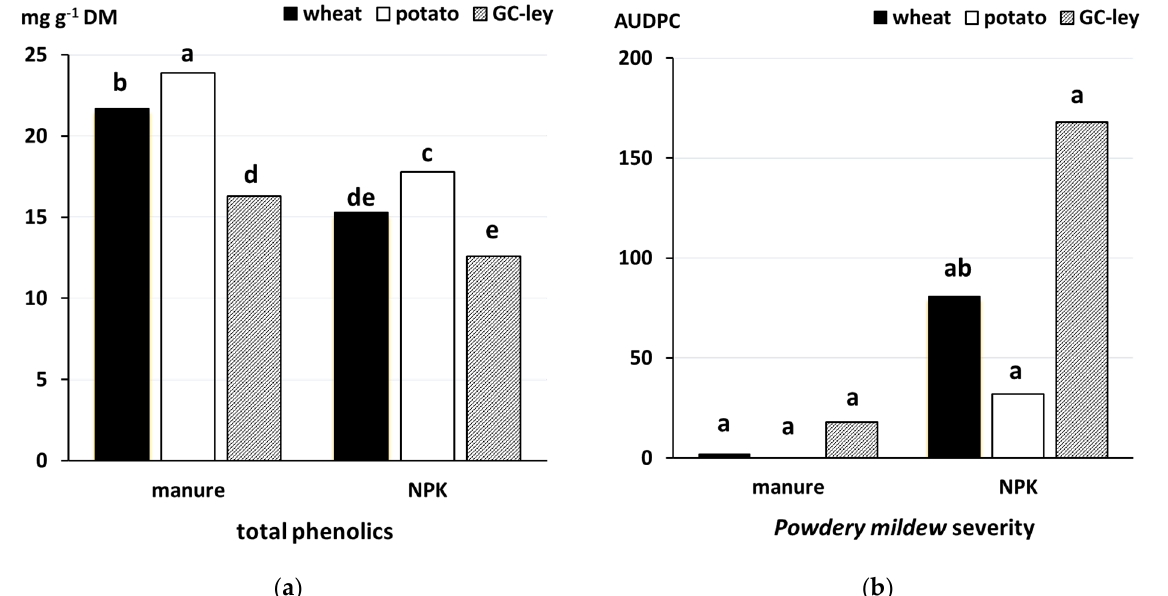
Figure 3. Effect of fertilization regime (F; manure versus mineral NPK fertilizer applied at the same total N-input rate of 170 kg N hectare) and preceding crop (PC) on ( a ) total phenolic concentrations ( p = 0.089 for F×PC interaction), and ( b ) powdery mildew severity ( p < 0.001 for FxPC interaction) in wheat leaves data from [33]. Means labelled with the same letter are not significantly different (Tukey’s honest significant difference test, p < 0.05). AUDPC, area under the disease progress curve days x % severity; DM, dry matter.